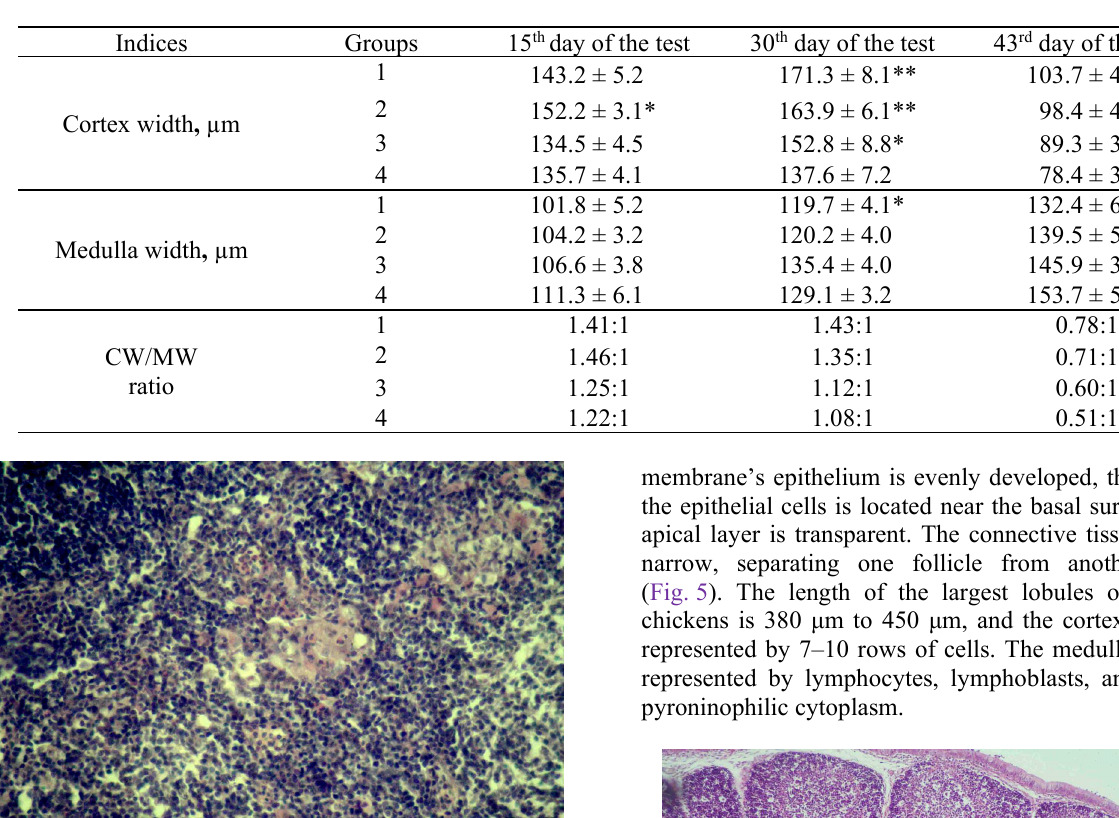
Dynamics of morphometric parameters of the broiler chicken’s thymus at the application of probiotic feed additives (M ± m, n = 10)